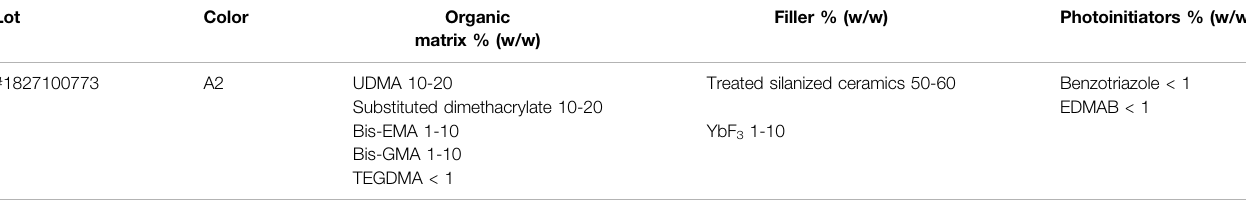
TABLE 1 | Filtek ™ bulk fi ll fl ow (RC) composition. Lot Color Organic